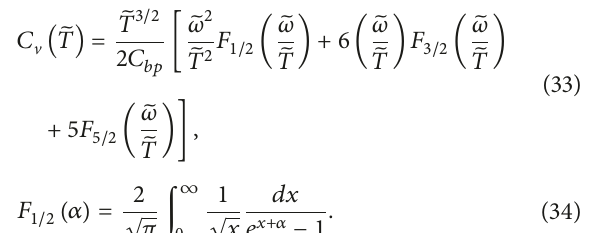
Figure 4: Temperature dependencies parameter values ̃𝜔 𝑖 presented in Figures 2 and